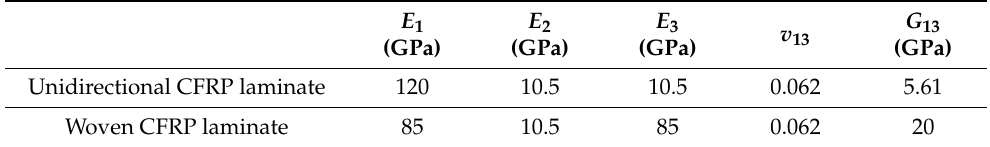
Table 3. Mechanical properties of CFRP laminate.